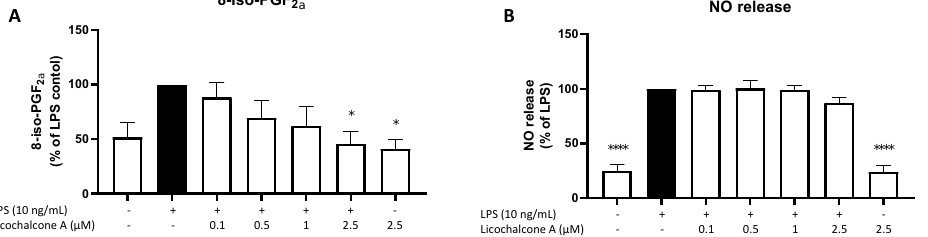
Figure 6. Effects of Licochalcone A on 8-iso-PGF 2 α ( A ) and NO ( B ) release in LPS-stimulated primary rat microglial cells. Cells were stimulated and 8-iso-PGF 2 α EIA or the NO Griess reagent assay performed as described under materials and methods. Values are presented as the mean ± SEM of at least three independent experiments. Statistical analysis was performed using one-way ANOVA with Dunnett’s post hoc tests with * p < 0.05, and **** p < 0.0001 compared to LPS-stimulated cells.